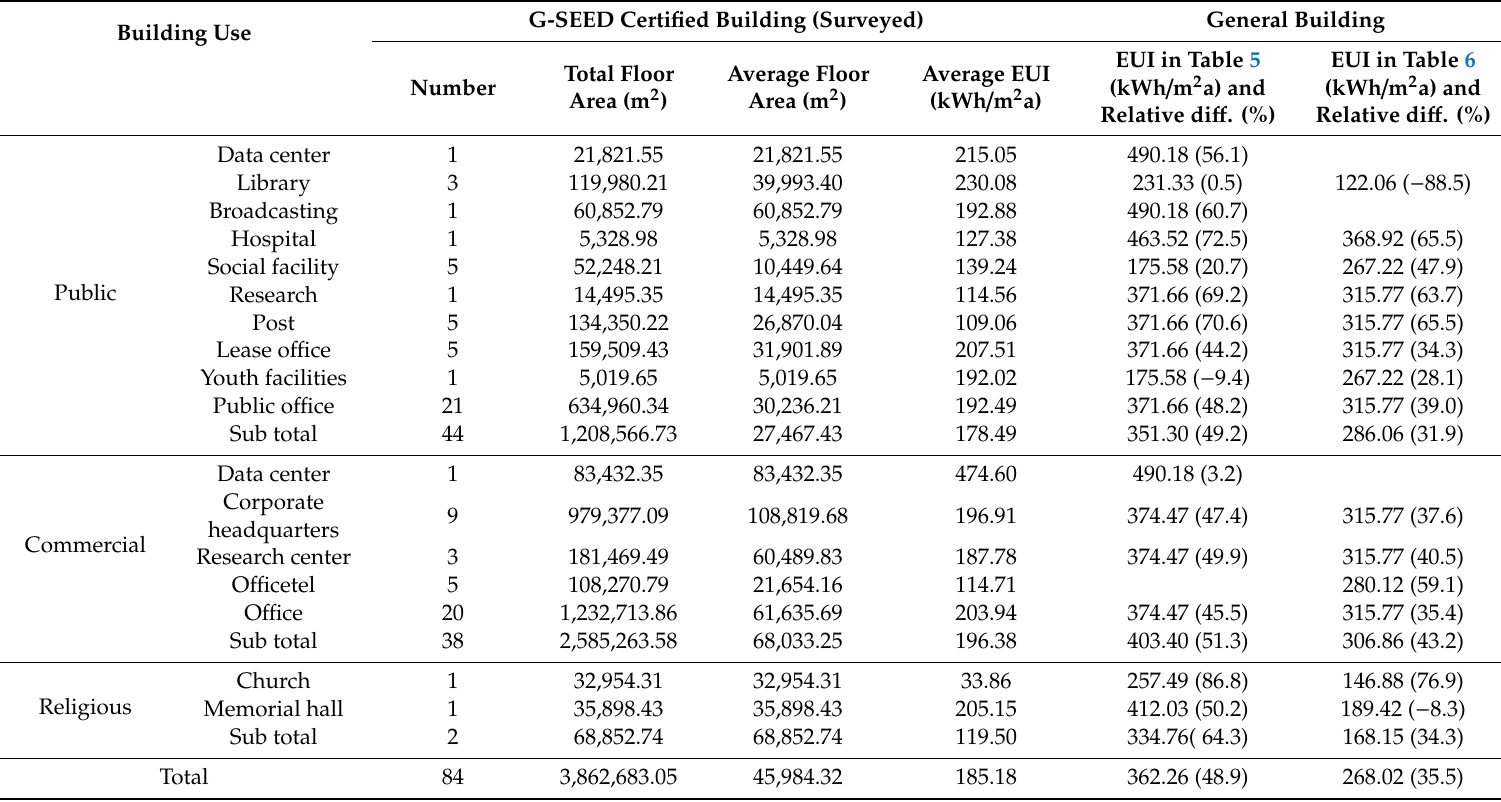
Table 9. Comparison of average EUI of G-SEED certified buildings and general buildings by building